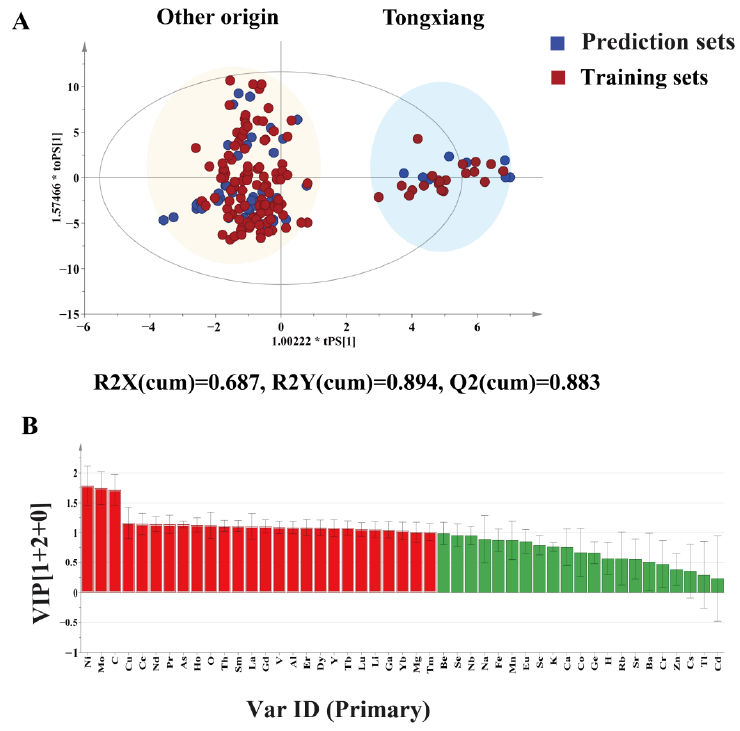
Figure 6. The OPLS-DA model ( A ) scores and ( B ) VIP value, the isotopic ratios and element identifi- cation results of samples from Tongxiang and other origins. Red columns indicate VIP ≥ 1, while green ones indicate VIP <